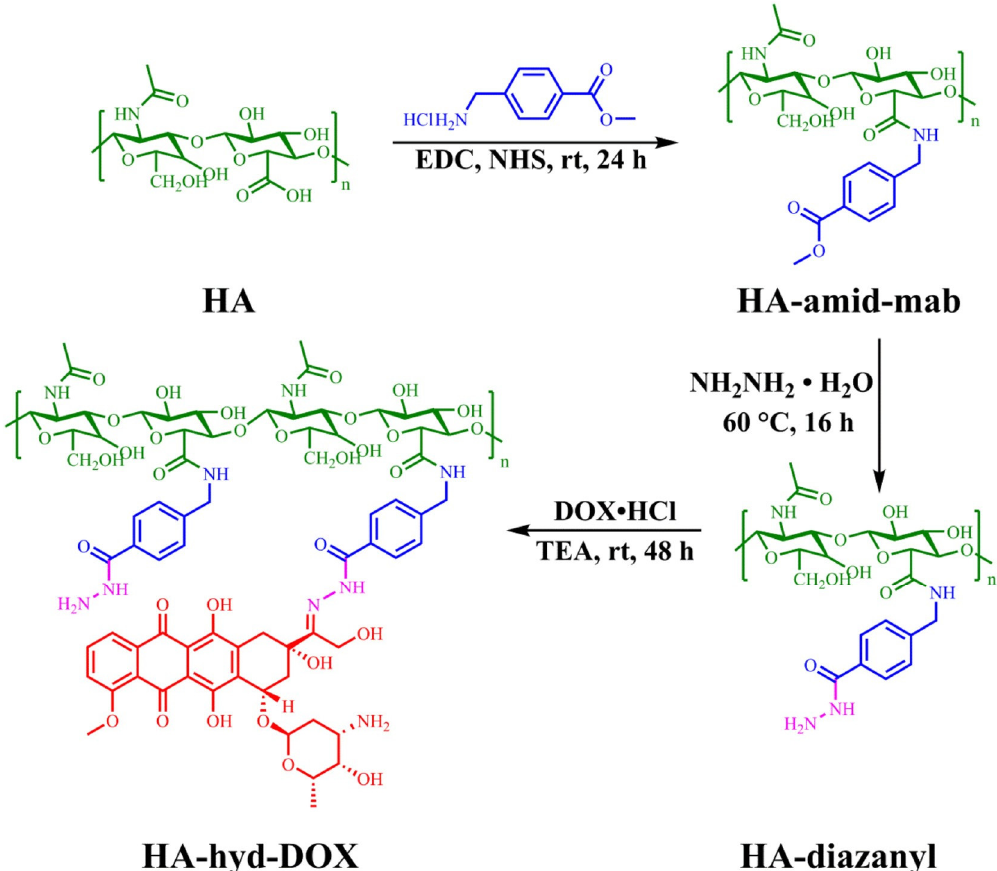
Figure 3. Synthetic routes of HA-hyd-DOX prodrugs. (Reprinted with permission from Ref. [62]. 2018, Jianhong Liao).